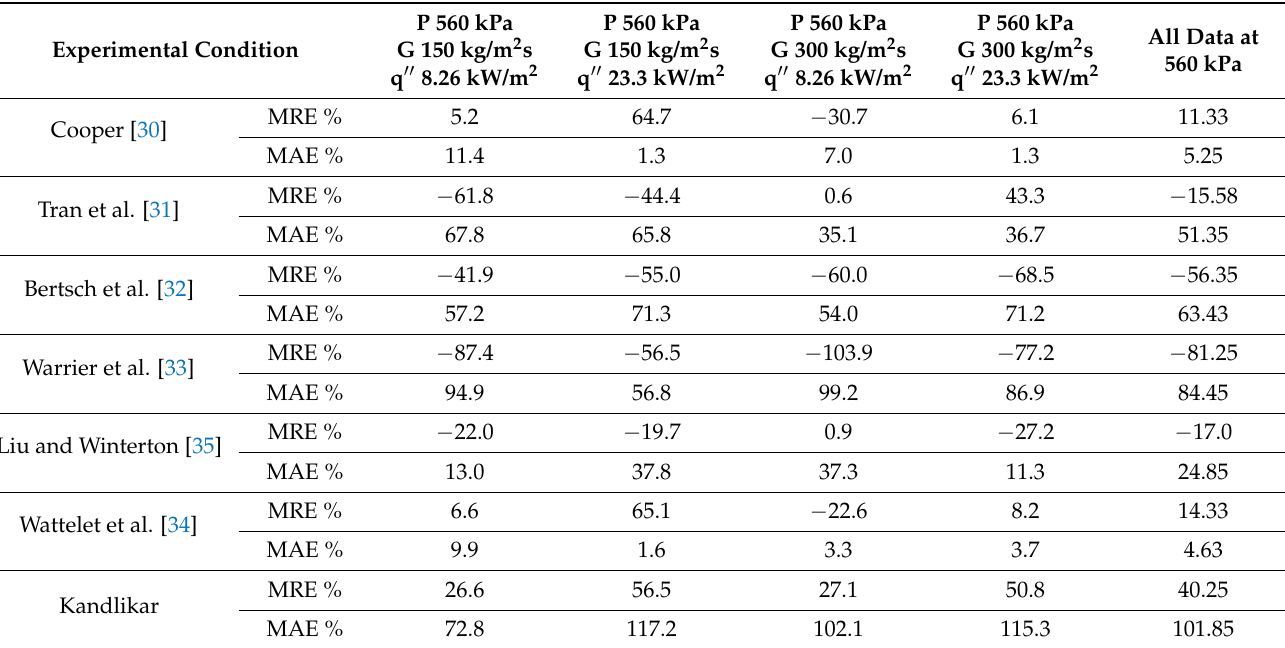
Table 7. Statistical analysis of the comparison between experimental heat transfer coefficient and prediction models at saturation pressure of 560 kPa.